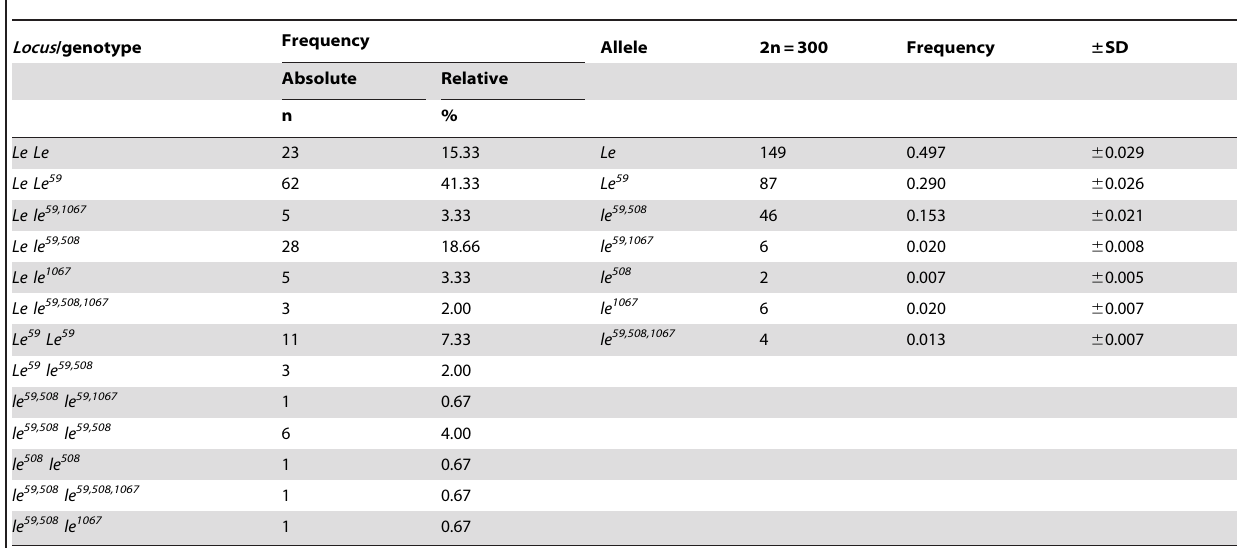
Table 2. Allele and genotype frequencies for the FUT3 loci analyzed in the sample from the population of Bele´m in the northeast Brazilian Amazon